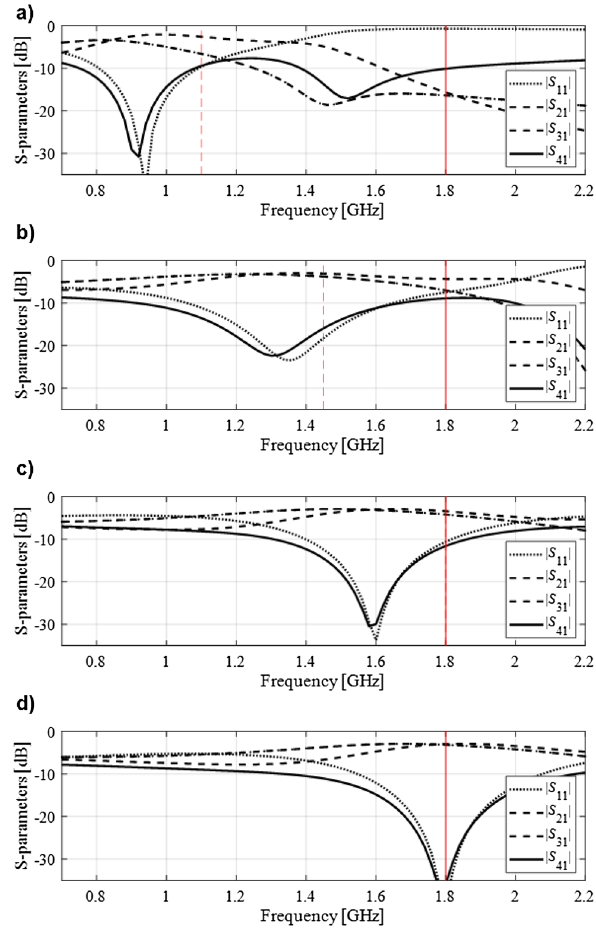
Figure 2. Automated design specification adjustment concept explained using a branch-line coupler. The initial design and the target operating frequency are the same as in Fig. 1 (initial design marked gray): ( a ) target frequency relocated towards the operating frequency at the initial design in order to ensure that the current specification (dashed line) are attainable from that design, ( b ) one of the iterations in the middle of the optimization run with the current design and current specifications, ( c ) final optimization stage; the target operating frequency converged to its original value, ( d ) final design optimized with respect to the original design